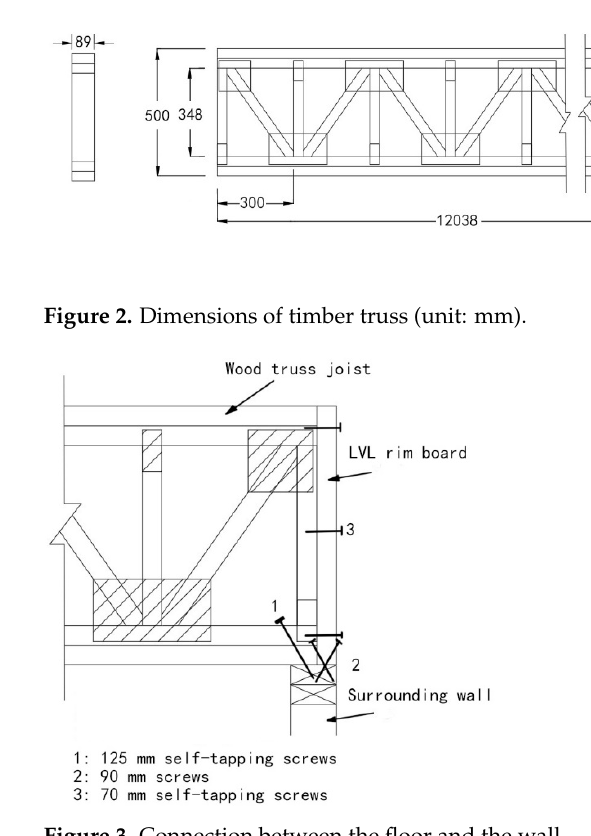
Figure 3. Connection between the floor and the wall.